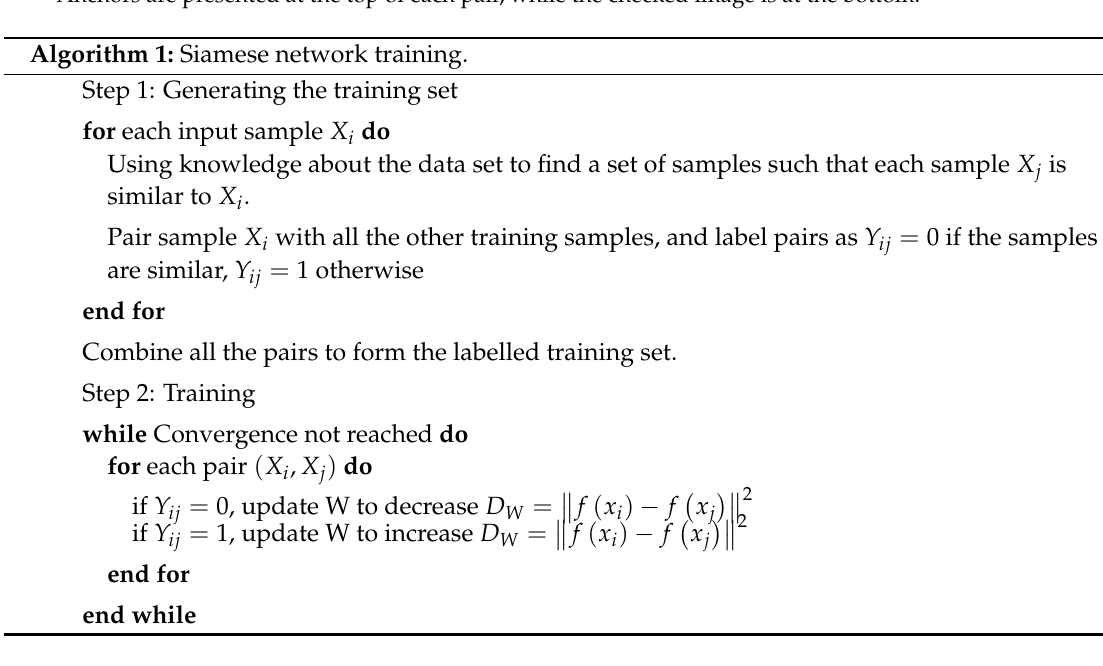
Figure 5. Examples of pairs used for training. The first pair - (a) - is a positive example, with label = 1; the following pairs are negative examples with label = 0, with green-yellow (b) and green-red (c) case. Anchors are presented at the top of each pair, while the checked image is at the